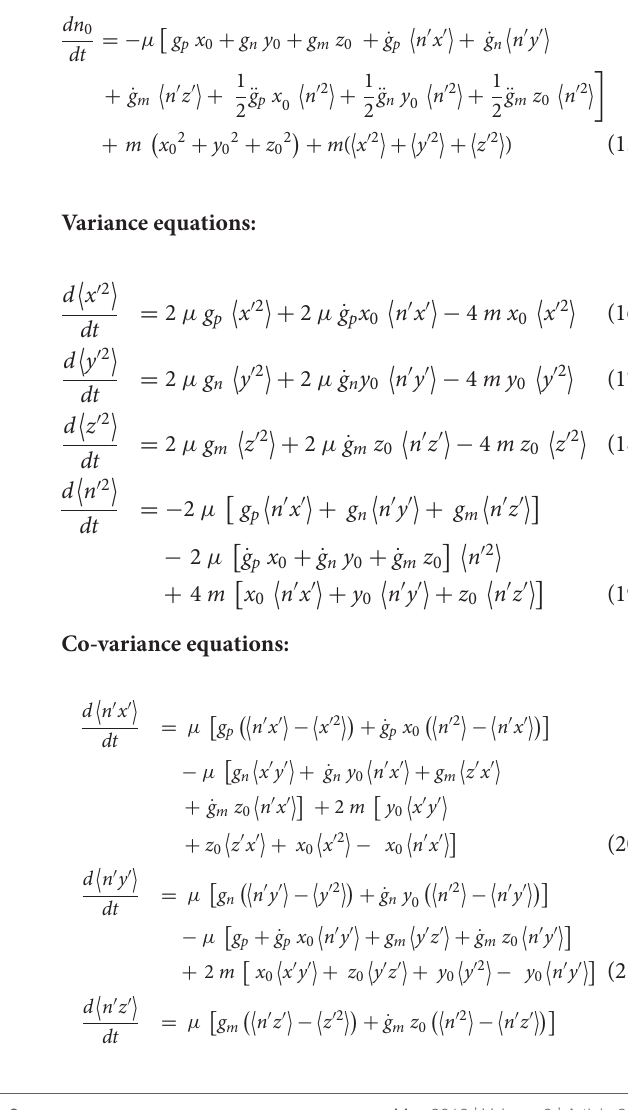
FIGURE 1 | (A) Compared to the typical mean-field assumption, the closure modeling approach (Mandal et al., 2014) accounts for the statistical distribution of chlorophyll in aggregates within each modeled grid-cell (green squares with internal variability), providing a more realistic representation than the typical assumption of uniformity within each grid cell (solid green squares), and predicting substantially different spatio-temporal patterns of growth response (Mandal et al., 2016). (B) The FlexPFT model ( Smith et al., 2016a) reproduces more realistic growth response and different biodiversity patterns, compared to typical inflexible models. Here we combine these two approaches to develop the first Flexible Closure